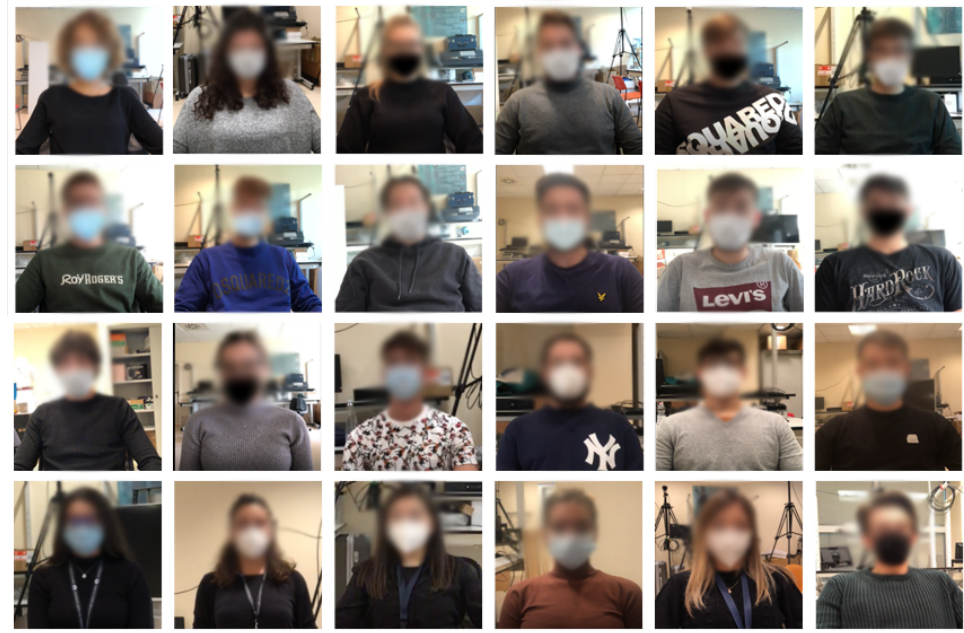
Figure 2. A picture of all the subjects just before the test is shown in the figure in order to show the variety of clothing